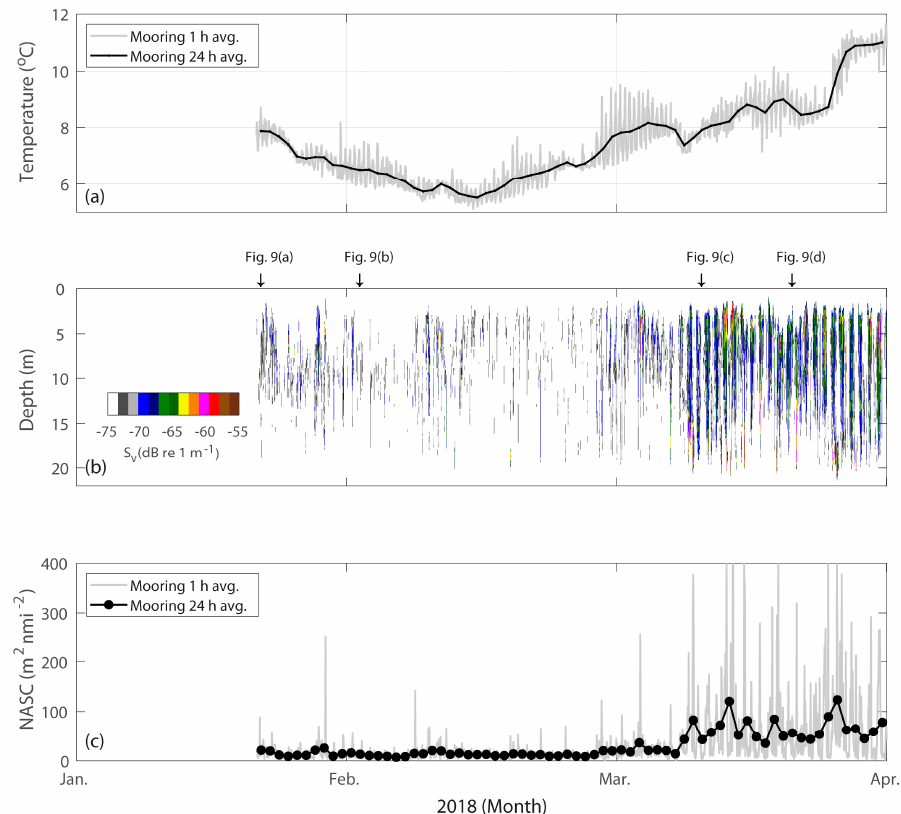
Figure 4. Temporal variability in water temperature and acoustic backscatter at a mooring site: ( a ) bottom water temperature, ( b ) volume backscattering strength (SV) (dB re 1 m − 1 ), and ( c ) nautical area scattering coefficient (NASC) (m 2 nmi − 2 ). The light gray lines indicate the average of the 100-ping ensembles collected hourly; the black lines and circles show the daily averages in ( a , c ).